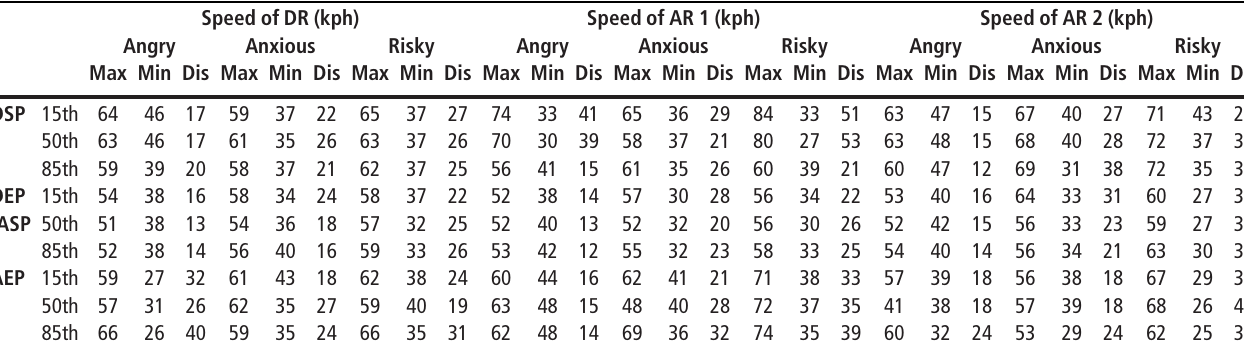
Table 5 Speed of feature points according to MDSI-C driving styles Speed of DR (kph) Speed of AR 1